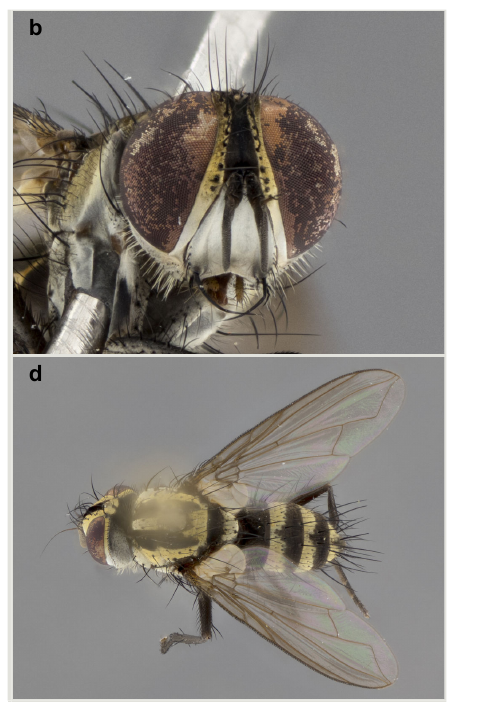
ef Figure 7. General morphology of Calolydella bifissus sp. n. ; a–c : male holotype, voucher